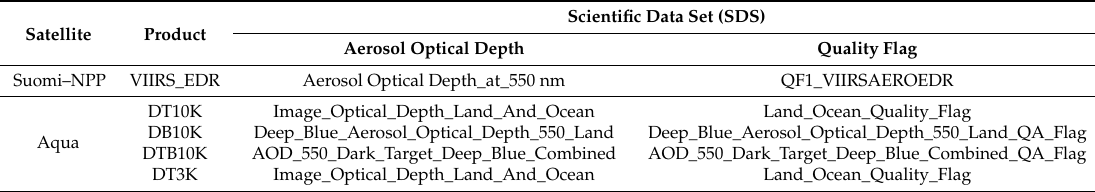
Table 1. Characteristics of Aqua-MODIS C6 and VIIRS_EDR AOD products used in this study over